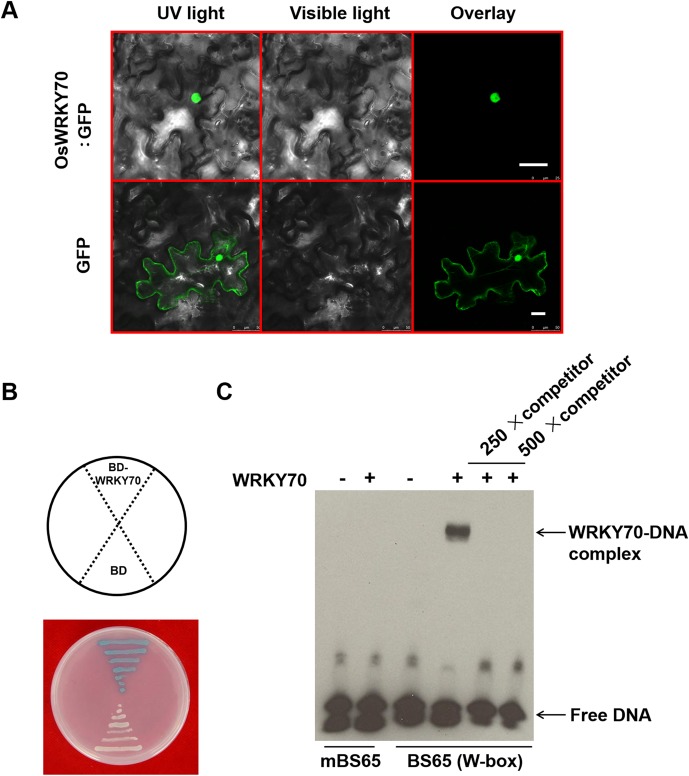
Subcellular localization, DNA-binding ability, and transcriptional activation activity of OsWRKY70.(A) Subcellular localization of OsWRKY70. N. benthamiana cells were transformed with GFP and OsWRKY70:GFP. After incubation for 48 hr, the transformed cells were observed under a confocal microscope. The photographs were taken in UV light, visible light, and in combination (overlay), respectively. Scale bar, 25 μm. (B) Transcriptional activation activity of OsWRKY70 in yeast cells. Y187 yeast cells containing pGBKT7 and pGBKT7-WRKY70, respectively, were plated on SD medium (−Trp) containing X-α-gal at 30°C for 12 hr and then the color was observed. (C) W-box binding ability of OsWRKY70 analyzed by electrophoretic mobility shift assay (EMSA). The recombinant OsWRKY70 protein can bind the W-box sequence BS65 but not to the mutant probe mBS65. Competition experiments were performed using unlabeled BS65 as a competitor in a 250-fold molar excess. This experiment was repeated twice with similar results.